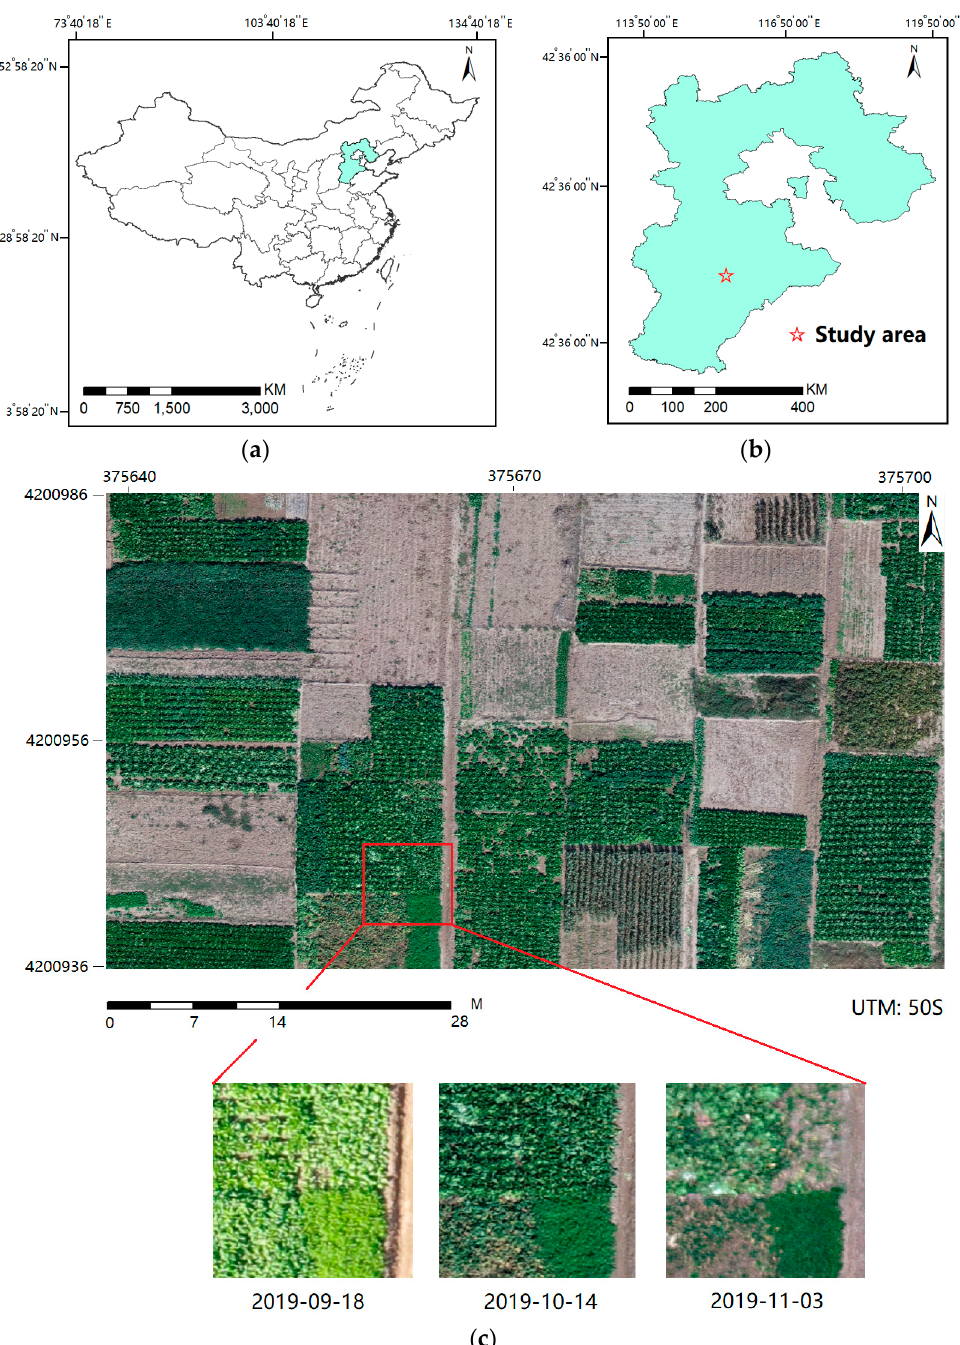
Figure 1. Study area. ( a ) China; ( b ) Hebei Province; and ( c ) Xijingmeng Village and multi-temporal UAV images.